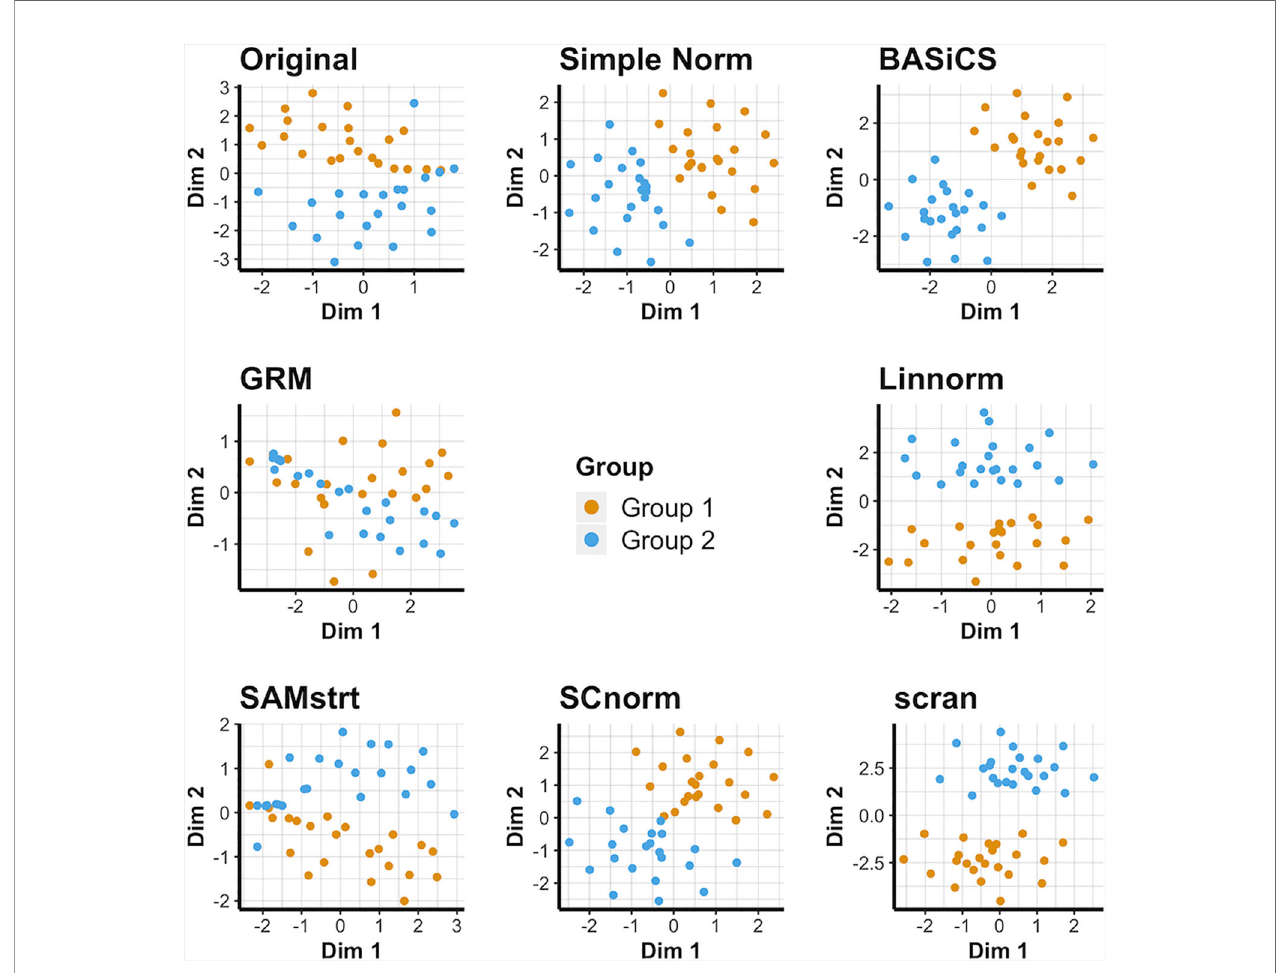
FIGURE 3 | t-SNE plots for the 2-fold change simulated data set under various normalization methods, with the original data for